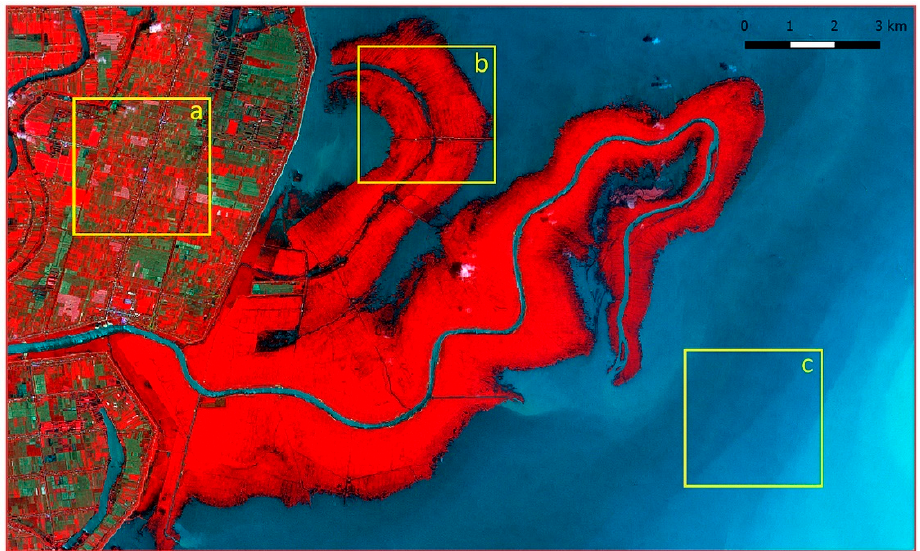
Figure 5. High-resolution false-color (NIR, green, blue) Sentinel-2 image (June 27, 2017) for southern Greece / Turkey containing DL ( a ), TFV ( b ) and TOW ( c ).